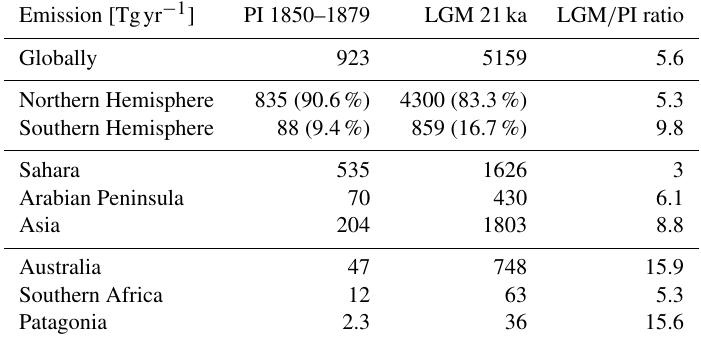
Table 3. Global and regional dust emissions during the PI and LGM in Tgyr − 1 and the LGM / PI